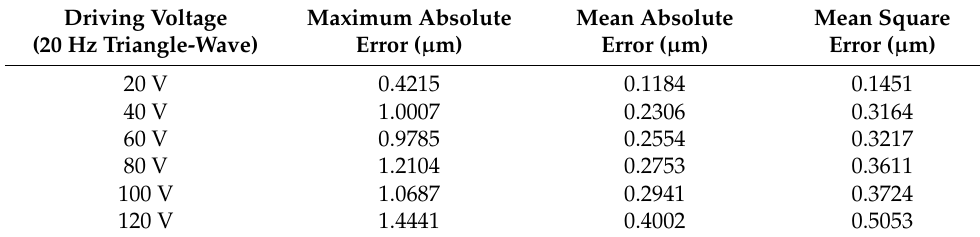
Table 2. MPI model accuracies on variable voltage